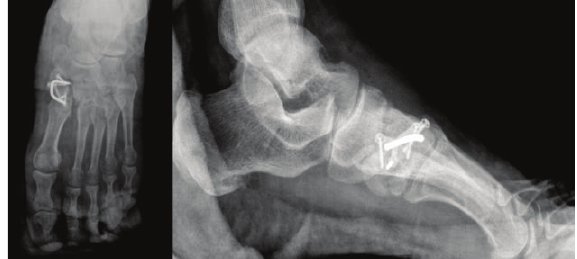
Figure 1: Preoperative anteroposterior and lateral X-ray.